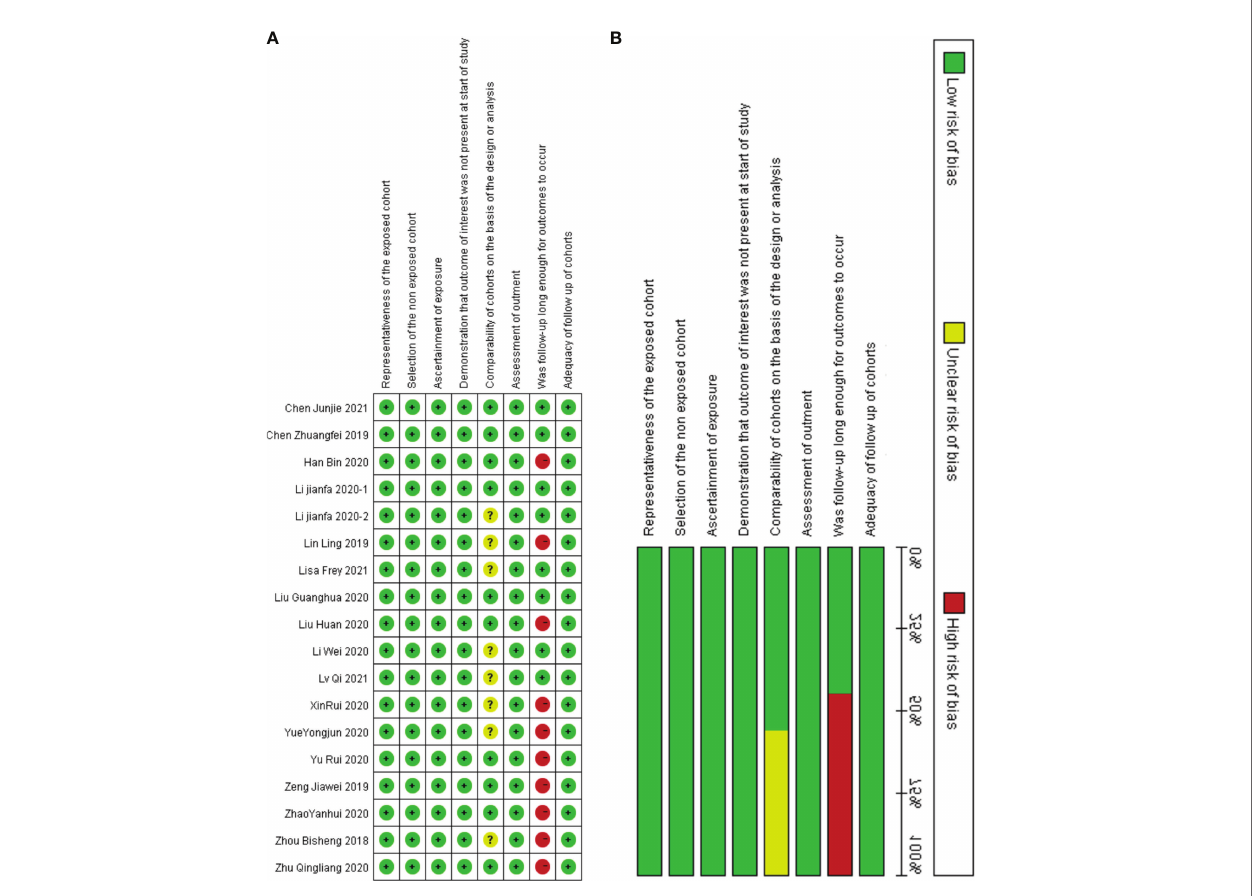
FIGURE 2 | Quality assessment by the NOS. (A) each bias risk item for each included study; (B) each bias risk item is presented as a percentage for all included